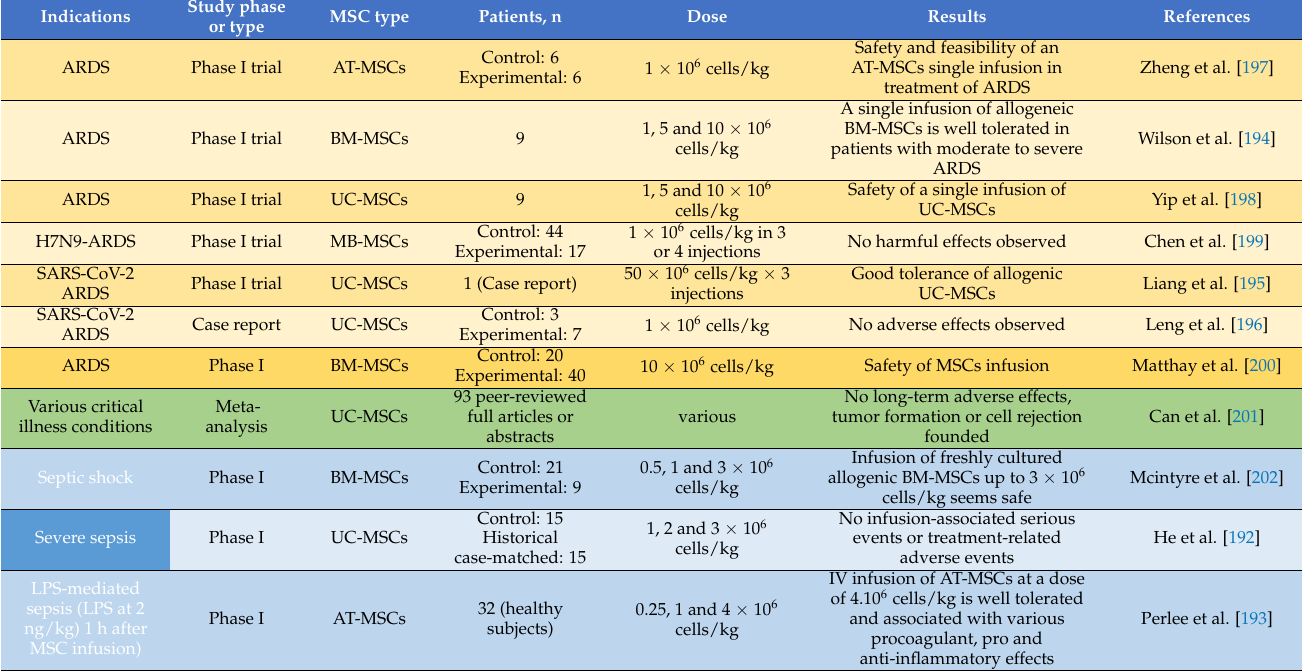
Table 2. Clinical trials about the use of allogeneic MSCs in inflammatory and septic states classified according to indications and trial